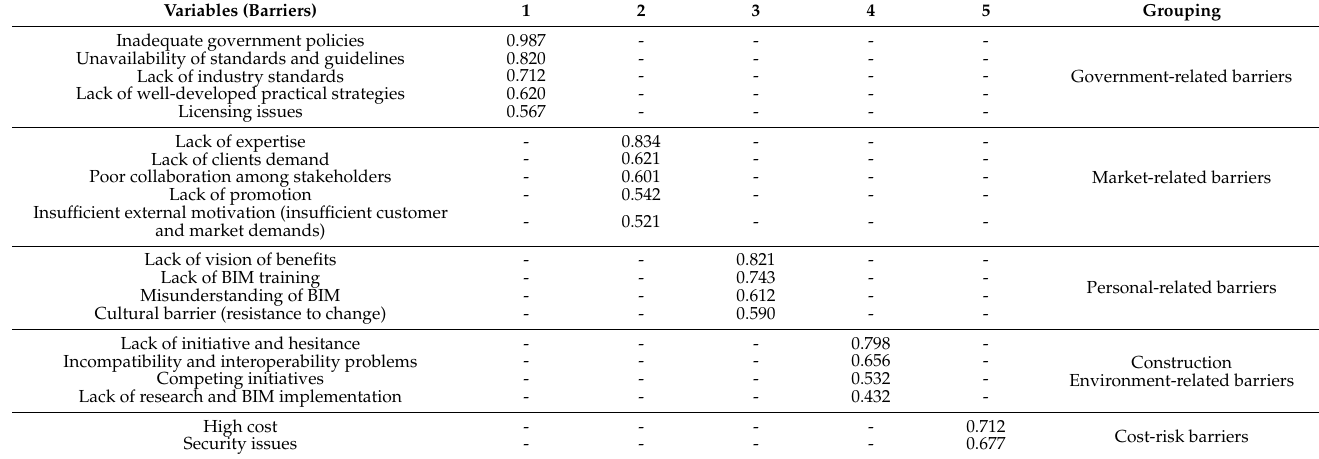
Table 5. Results of factor analysis (FA) on barriers to BIM implementation in sustainable building projects. Variables (Barriers)